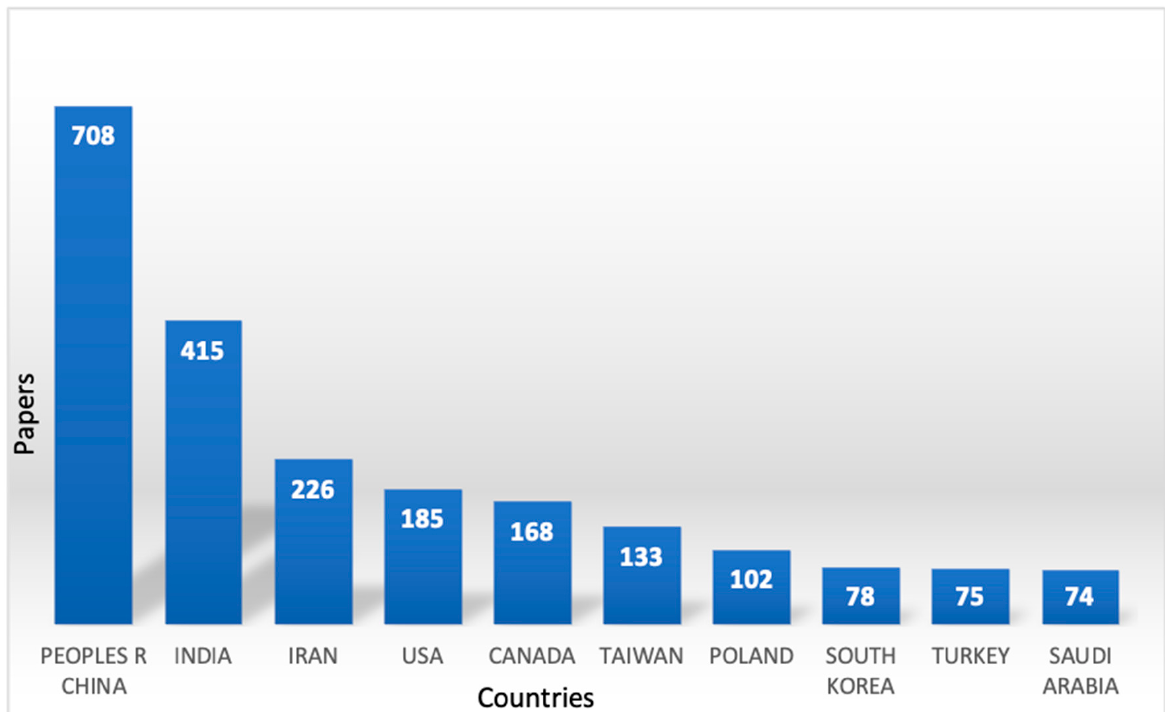
Figure 2. Plot of 2225 papers of Web of Science for topic: (optimization fuzzy clustering) by countries.